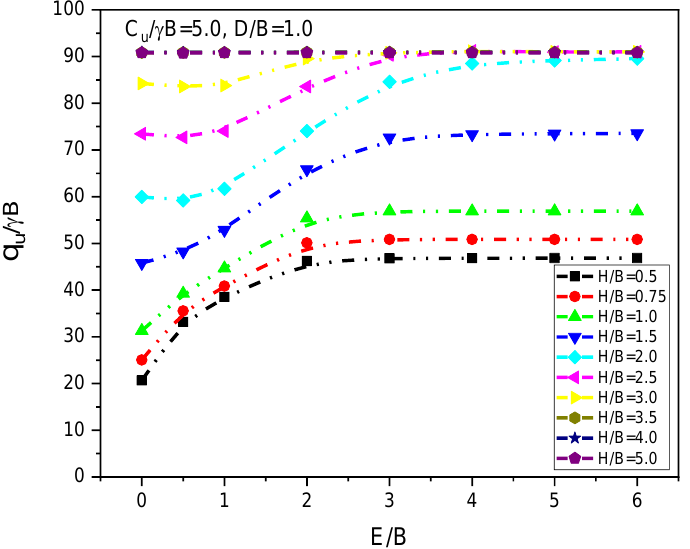
Figure 7. Effect of E/B on the ultimate bearing capacity ratio qu/γB.